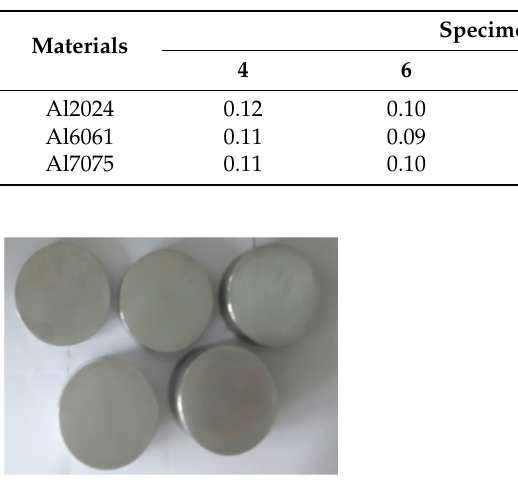
Figure 6. Aluminum specimens after surface